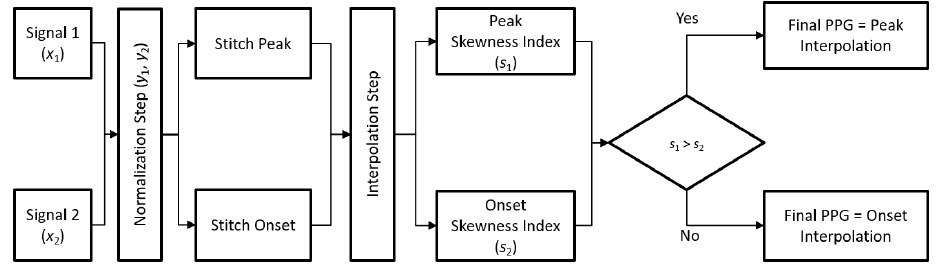
Figure 2. Flowchart for stitching two PPGs together. The “Peak” refers to the systolic